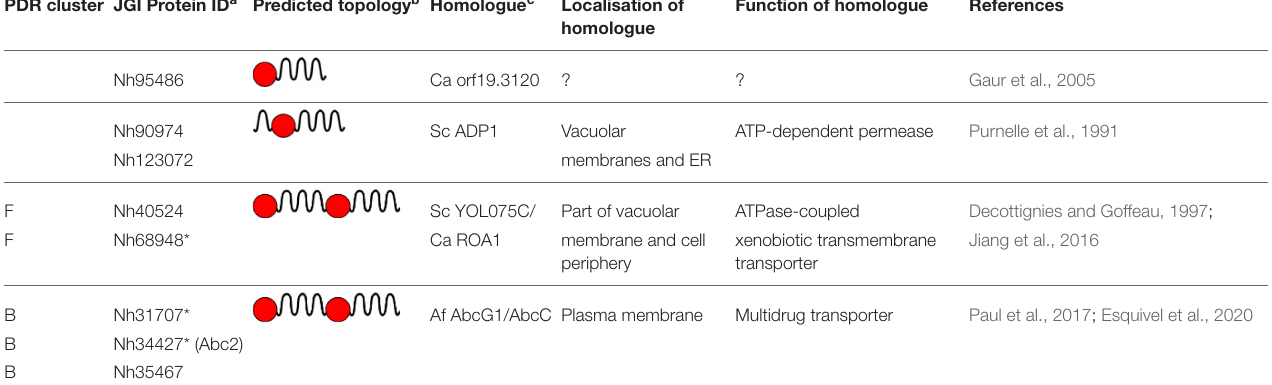
TABLE 3 | ABCG protein inventory of Nectria haematococca mpVI 77-13-14 and their putative function based on their homology to A. fumigatus (Af), S. cerevisiae S288C (Sc) or C. albicans SC5314 (Ca) homologues. PDR cluster JGI Protein ID a Predicted topology b Homologue